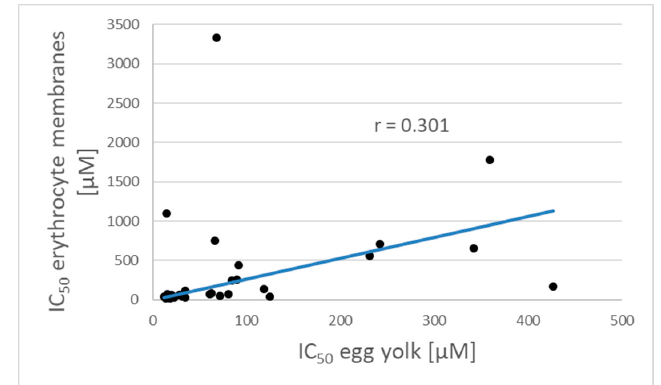
Figure 1. Correlation between IC 50 values of antioxidants presented in Table 1 in two systems of lipid peroxidation: egg yolk suspension and erythrocyte membranes.